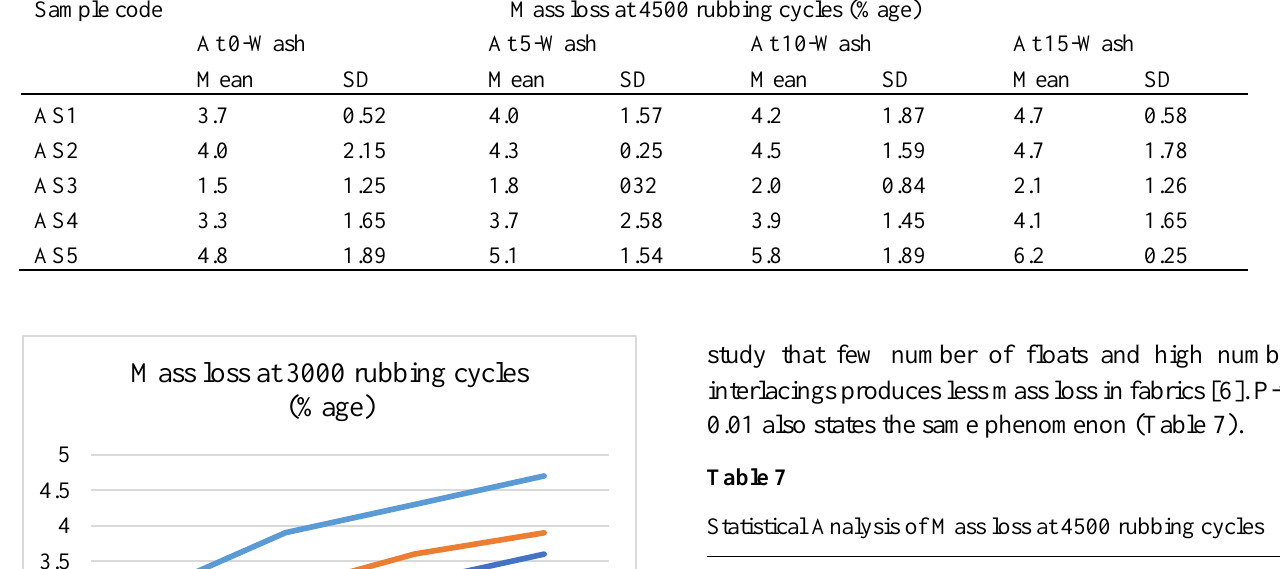
Mass loss at 4500 rubbing cycles at various washing intervals Sample code